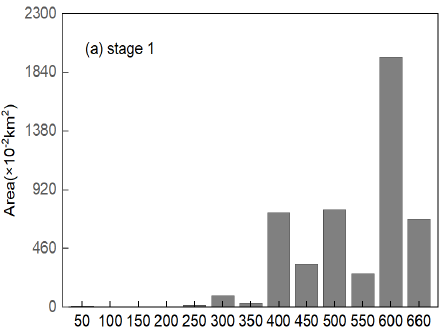
Figure 7. Spatial distribution and changes in the number of MCBs in different impoundment periods: ( a ) stage 1, ( b ) stage 2, ( c ) stage 3, ( d ) stage 4 and ( e ) stage 5.